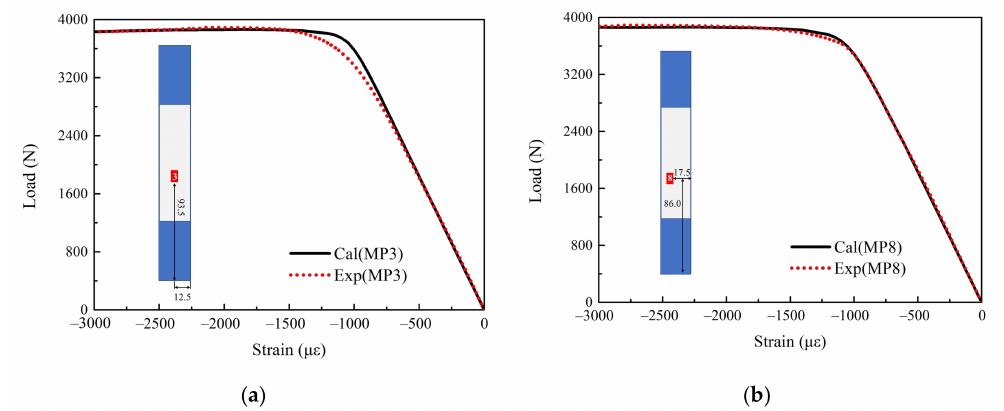
Figure 15. Comparison between identification results and experimental load–strain curves. ( a ) Com- parison between the identification result and the experimental load–strain curve at MP3; ( b ) compari- son between the identification result and the experimental load–strain curve at